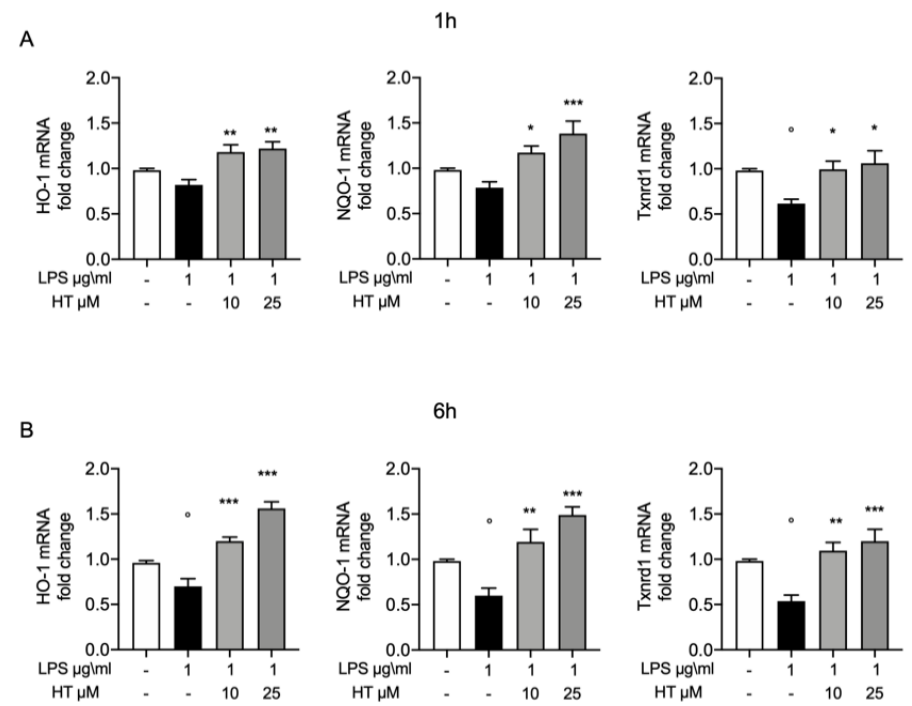
Figure 5. ( A ) Protective e ff ect of HT in LPS induced oxidative stress in MAC-T cell: mRNA levels of HO-1, NQO-1 and Txnrd1 one hour post LPS 1 µ g / mL stimulation and 10- µ M and 25- µ M HT treatment; ( B ) mRNA levels of HO-1, NQO-1 and Txnrd1 six hours post LPS 1- µ g / mL stimulation and 10- µ M and 25- µ M HT treatment. Data representative of at least three experiments, means ± SEM; ◦ p < 0.05 vs. control; * p < 0.05 vs. LPS; ** p < 0.01 vs. LPS; *** p < 0.001 vs. LPS.